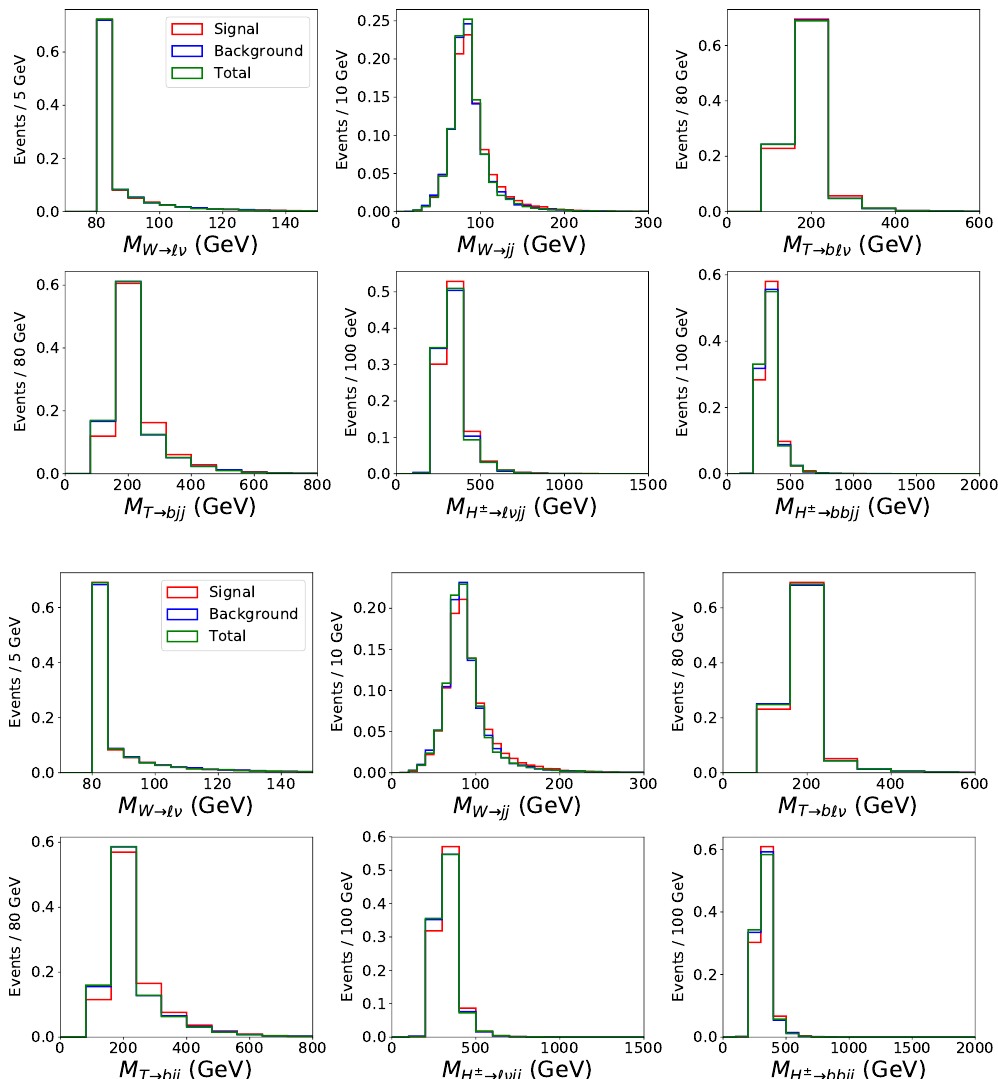
Figure 9 . Invariant mass distributions for reconstructed particles in the m mod+ model independent. Bottom: model